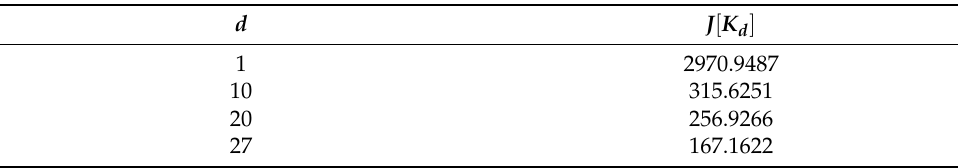
Table 1. Solution results for different mini-batch sizes.